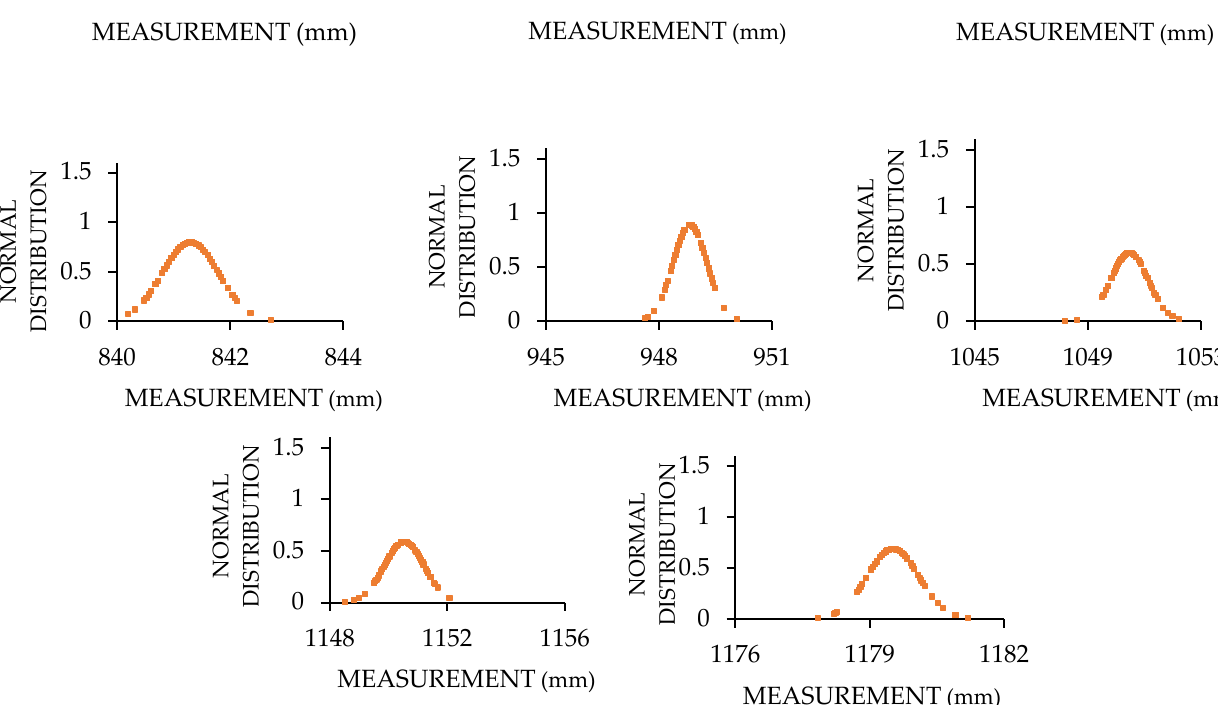
Table 8. Statistical analysis of HC-SR04 values (those written in red do not follow the normal dis- tribution).